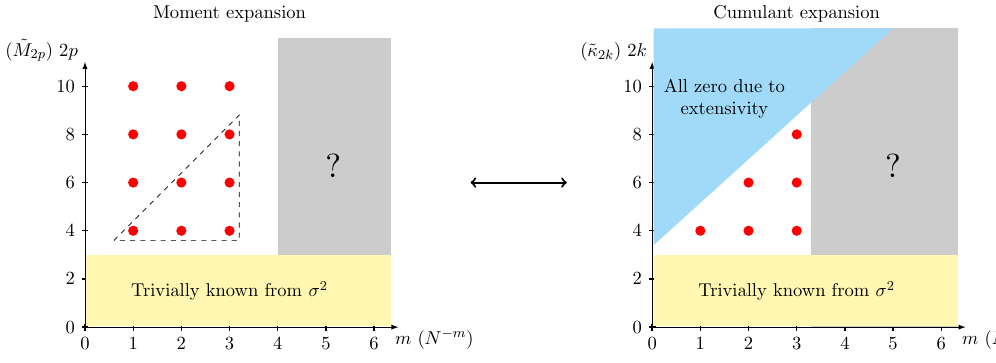
Figure 1 . Relation between two expansions (for even q ). The horizontal axes denote orders in 1 =N , while the vertical axes denote orders in (scaled) moments and cumulants. The red dots are where the corresponding 1 =N coe(cid:14)cients are known, and the gray region is unknown. It is interesting